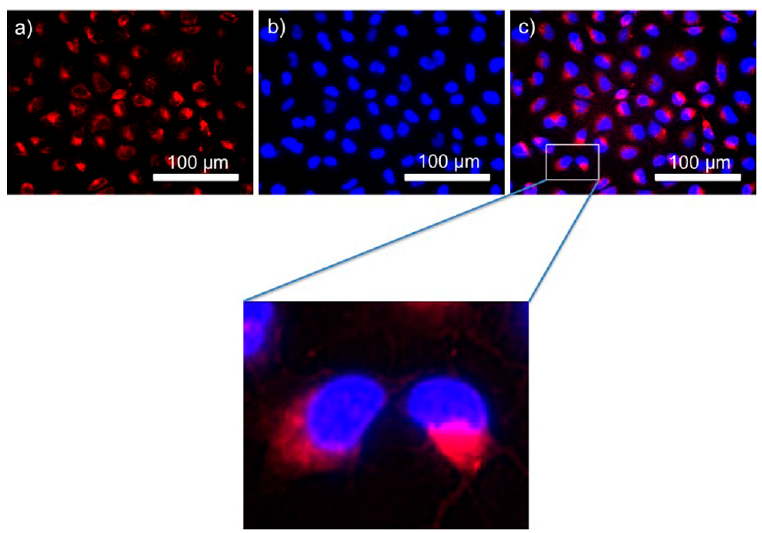
Figure 6. ( a ) Fluorescence imaging of A549 cells after incubating with Cy5-BF 3 ( 19 F) (2 µM, 1 h, red); ( b ) Fluorescence imaging of A549 cells after incubating with Hoechest 33258 (1 µg/mL, 1 min, blue); ( c ) The overlay of ( a , b ).